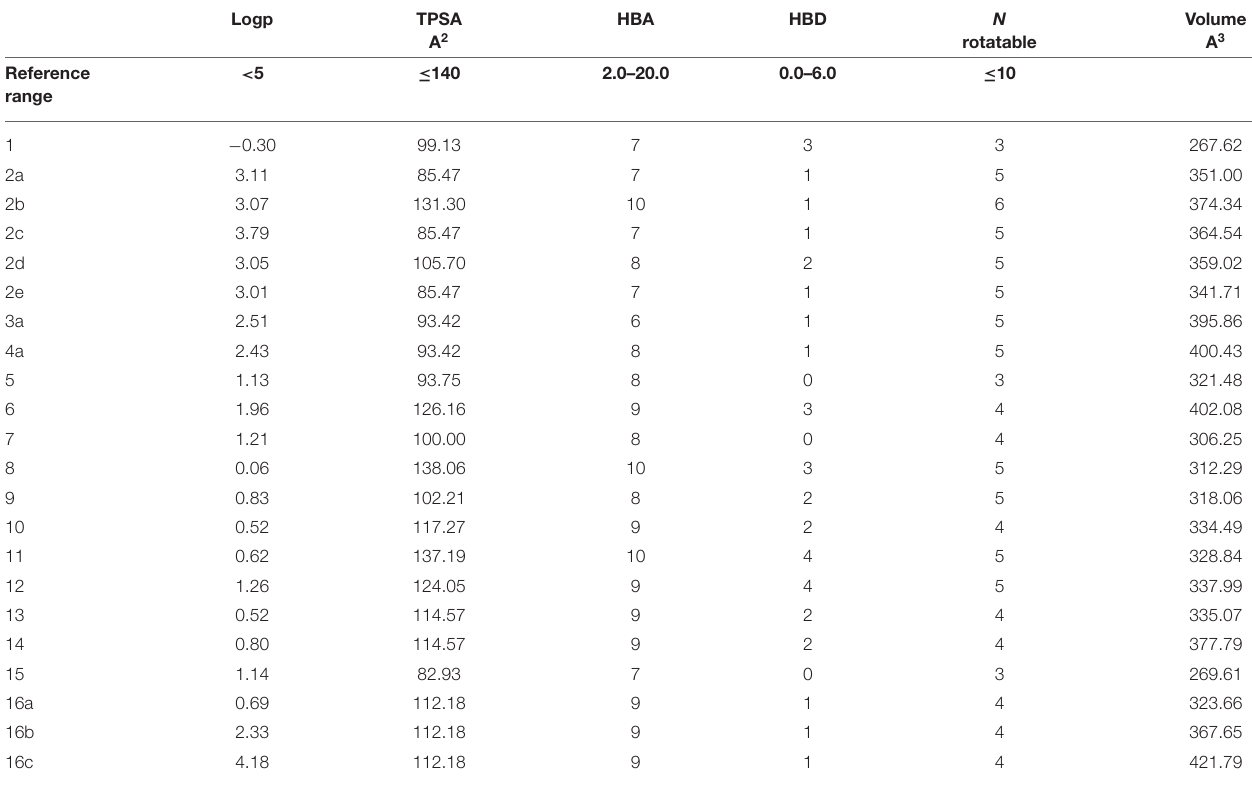
TABLE 3 | Physicochemical properties of the title compounds 1–16.